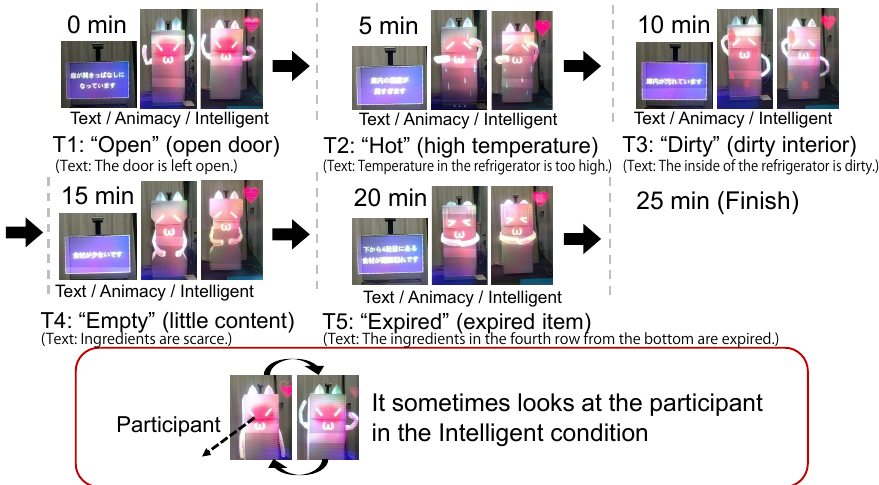
Figure 3. AR state visualization in each subtask (T1–T5). ( Left in the triplet) Text condition, ( middle in the triplet) Animacy condition, ( right in the triplet) Intelligence